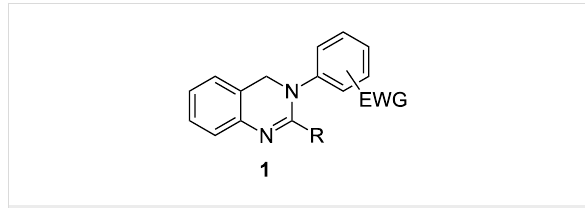
Figure 1: N -Aryl-3,4-dihydroquinazolines 1